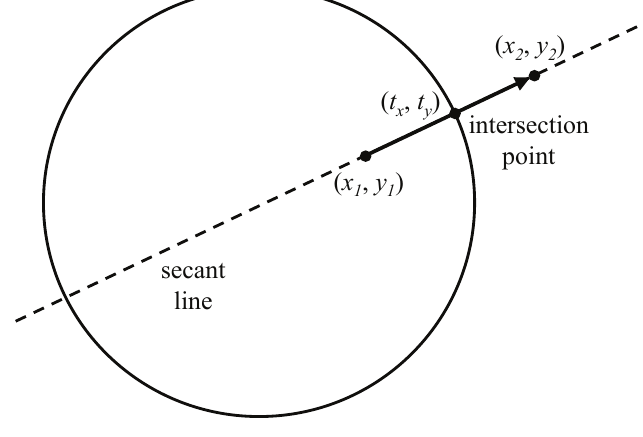
Figure 2. Circle and secant